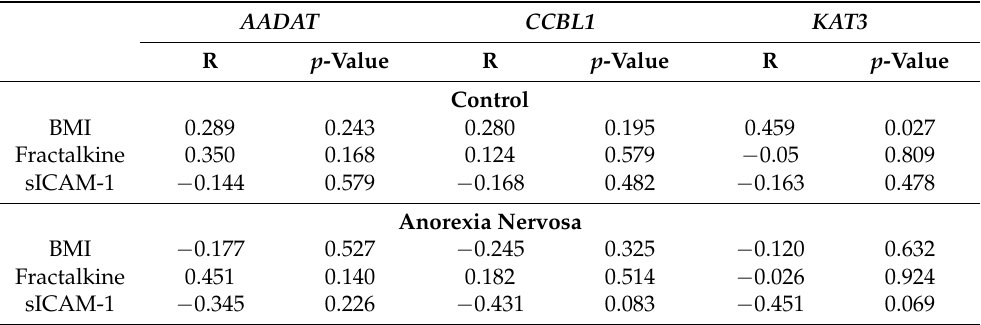
Table 5. Correlations of fractalkine, sICAM-1 and BMI with CCBL1, AADAT and KAT3 in anorexia